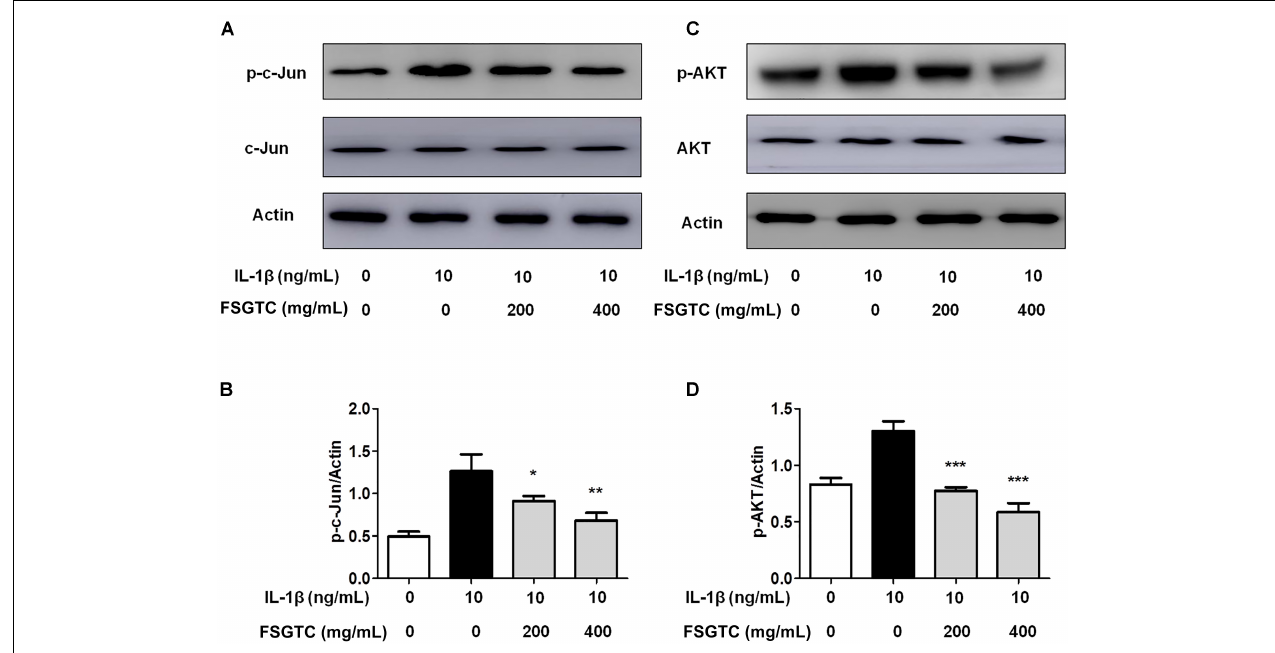
FIGURE 7 | Effects of FSGTC on IL-1 β -induced activation of AP-1 and Akt in SW982 cells. The cells were treated with various doses (200 and 400 mg/mL) of FSGTC. Lysates were prepared and Western blot performed using specific phospho-c-Jun (A) and phospho-Akt antibodies (C) . Histogram analysis for the expression levels of phospho-c-Jun (B) and phospho-Akt (D) as described above. Actin was used as an internal control. n = 3, x ± s . ∗ p < 0.05; ∗∗ p < 0.01, ∗∗∗ p < 0.001 vs. IL-1 β without